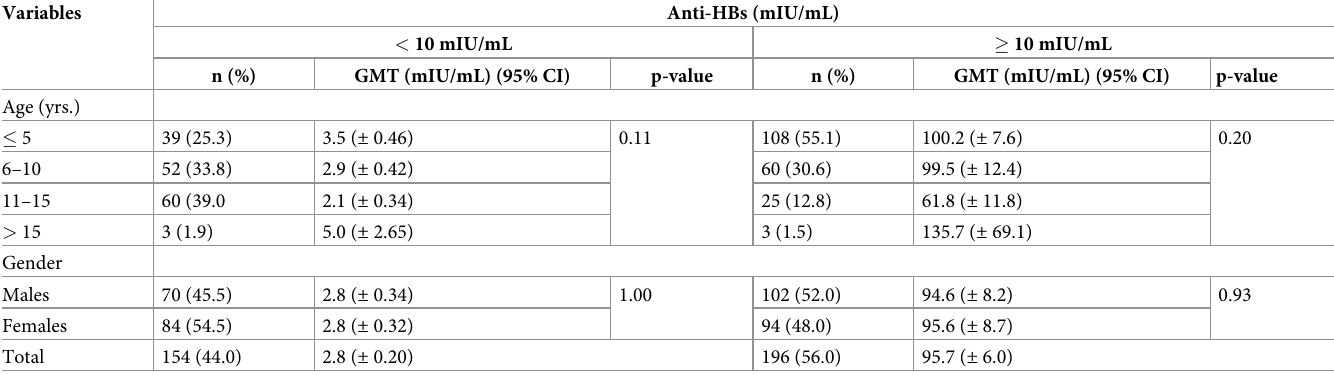
Table 1. Association of demographics and sero-protection